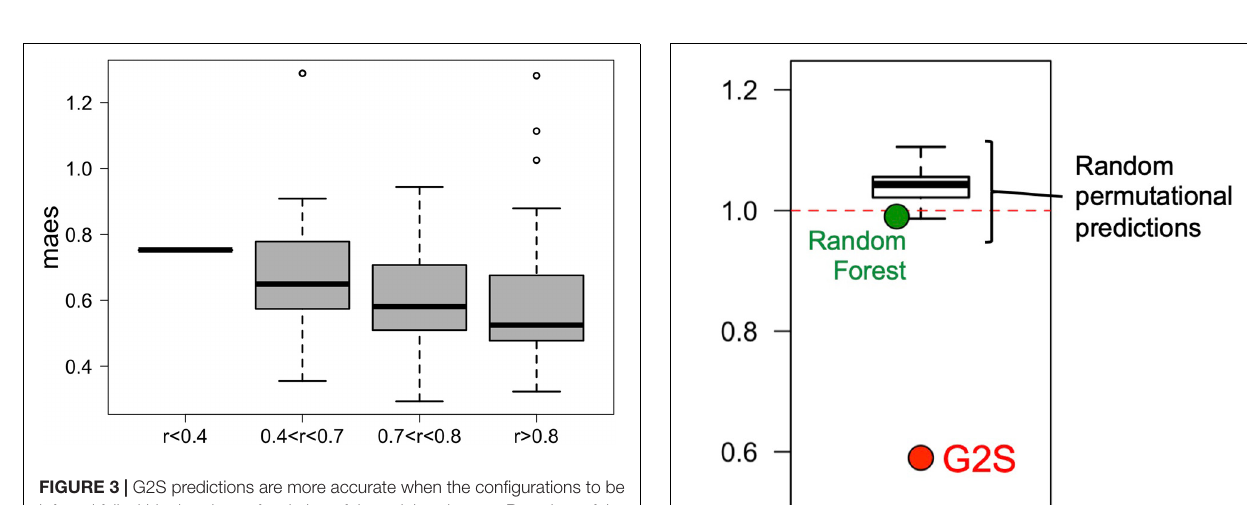
FIGURE 2 | Comparison between G2S predictions and real data from the test dataset. The family level bar plots of the 79 stool samples of the test dataset are visualized next to their inferred configurations obtained by G2S. Spearman correlation coefficients (r) are provided below each pair of bar plots. Samples are derived from the following studies: The Human Microbiome Project Consortium (2012), Zaura et al. (2015); Brito et al. (2016), Russo et al. (2018).